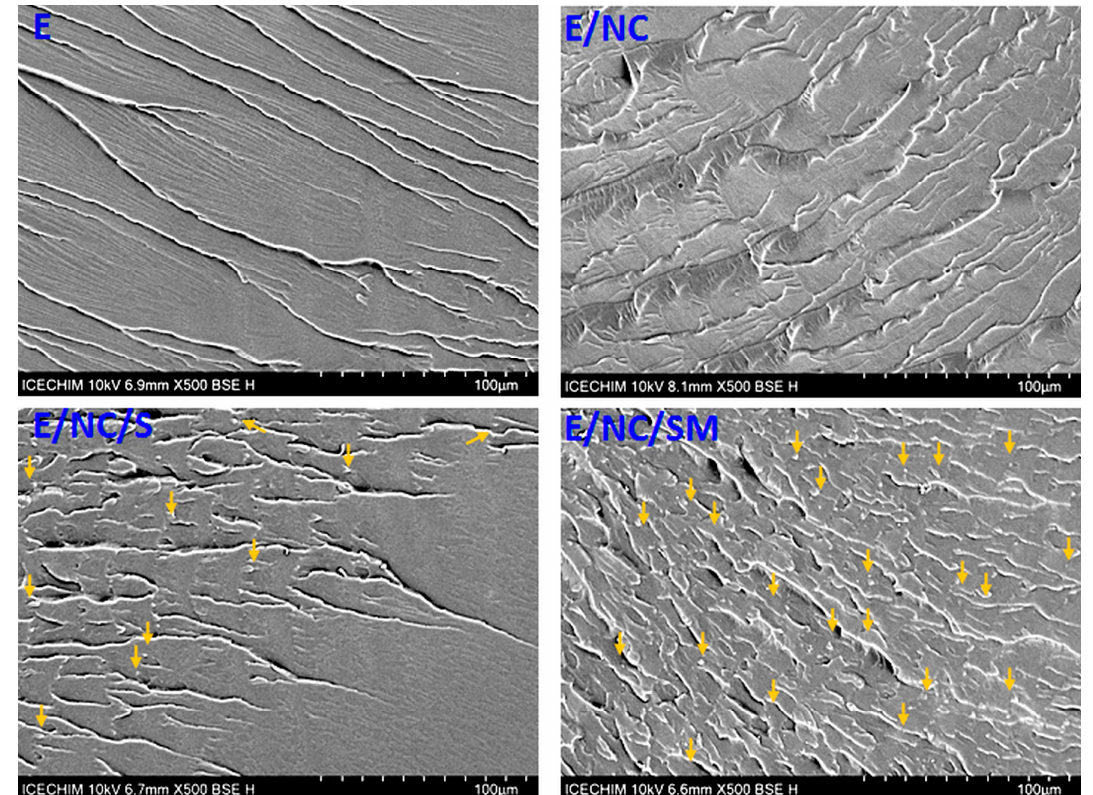
Figure 8. SEM micrographs of cryo-fractured surfaces of cured neat epoxy matrix and epoxy/NCs nanocomposites (×500).